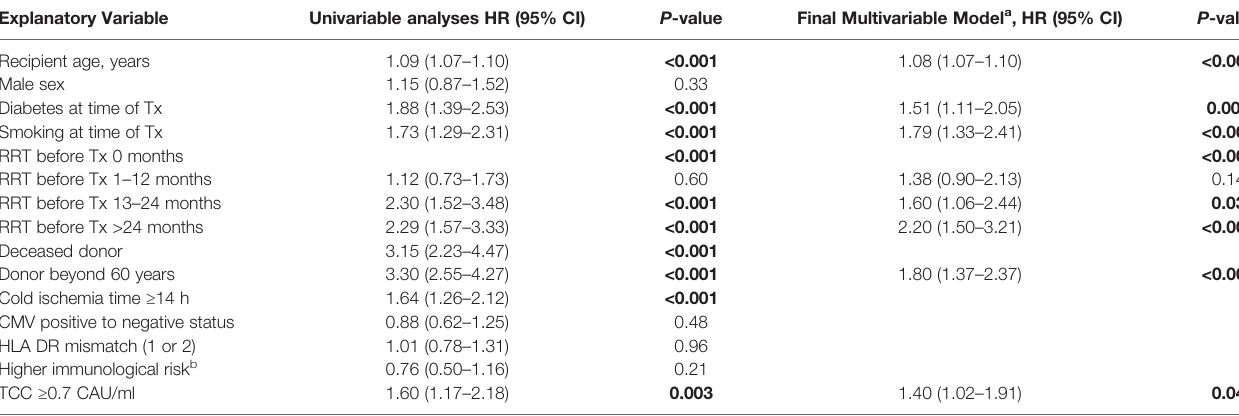
TABLE 2 | Univariable and multivariable Cox regression models with TCC for patient survival after kidney transplantation 2007 – 2012, n = 900. Explanatory Variable Univariable analyses HR (95% CI) P -value Final Multivariable Model a , HR (95% CI) P